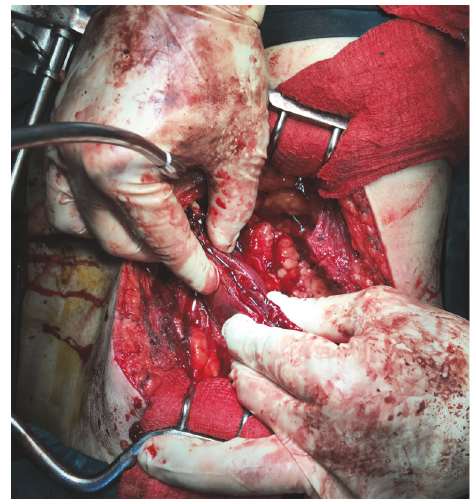
Figure 4: Intraoperative photo demonstrating manual compression of the renal parenchyma during the resection of the right renal tumor of the lower